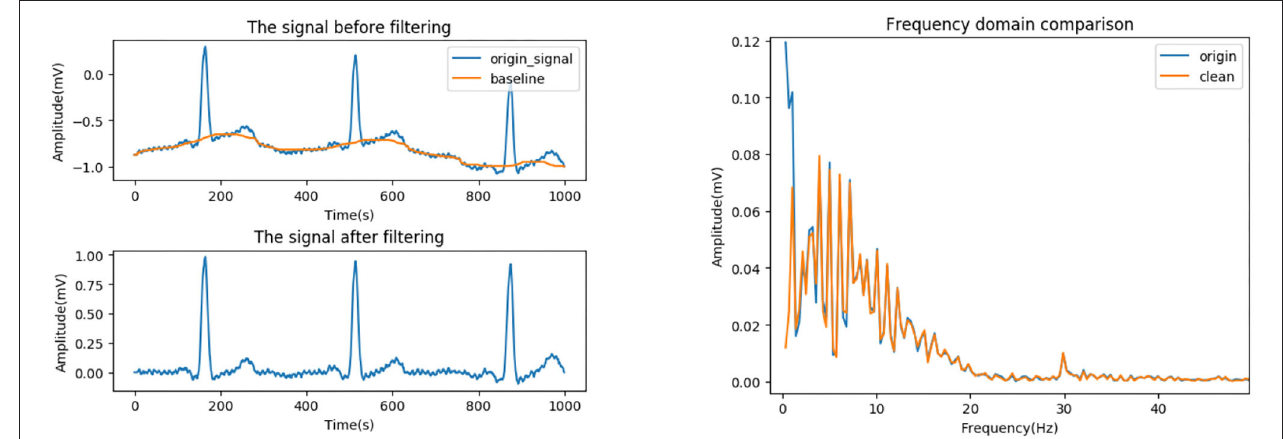
FIGURE 3 | Baseline drift removing. (Left) Time domain. (Right) Frequency domain.